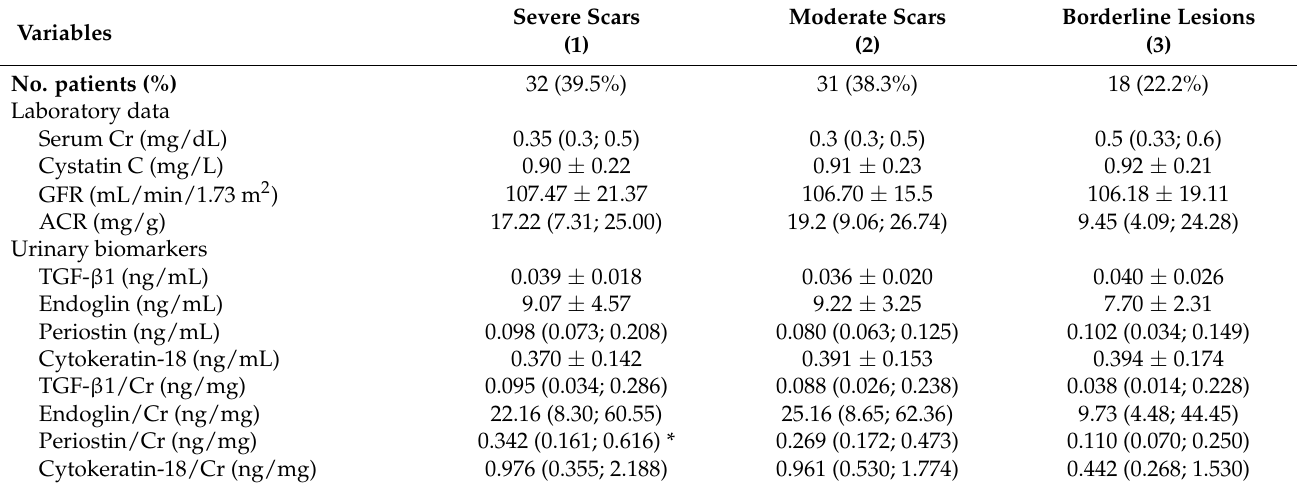
Table 2. Comparison of laboratory variables with the results of renal scintigraphy in the study